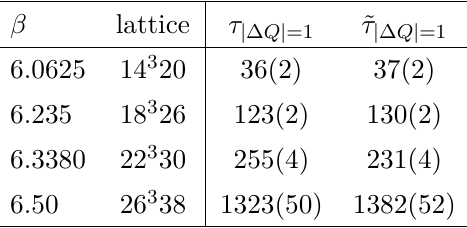
Table 24 . Average number of sweeps between changes in the topological charge by one unit, τ , on lattice volumes shown; ˜ τ is corresponding value scaled to a standard lattice | ∆ Q | =1 | ∆ Q | =1 √ volume V = (3 / σ ) 4 at each value of β .